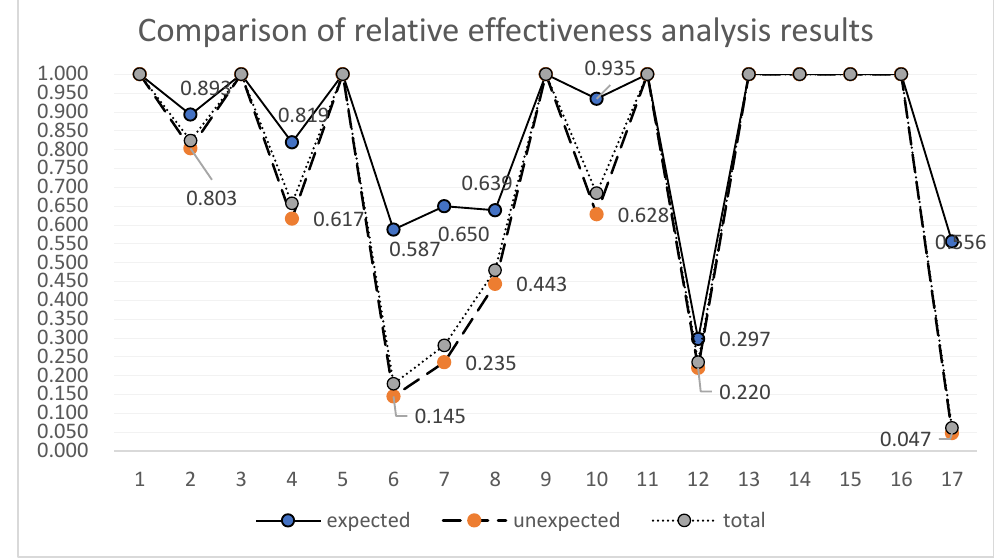
Figure 4. Comparison of relative effectiveness analysis results.